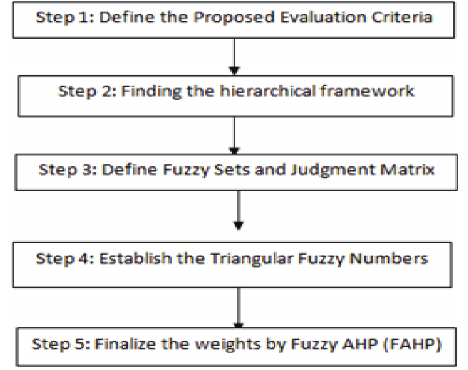
Fig.7. The Framework of proposed evaluation